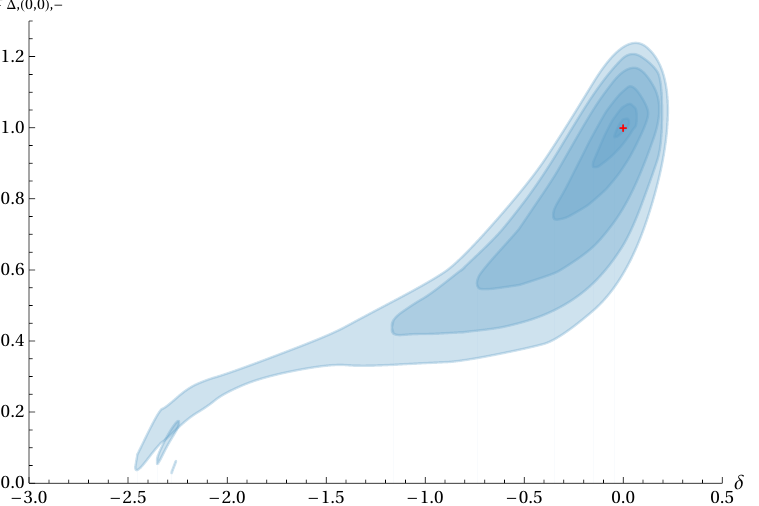
Figure 24 . Allowed region in the plane of the dimension and the OPE coe(cid:14)cient of a sin- gle relevant scalar charged operator. On the horizontal axis (cid:14) (cid:17) (cid:1) (0 ; 0) have been computed at (cid:3) = 16. Shaded regions corresponds to (from darker to